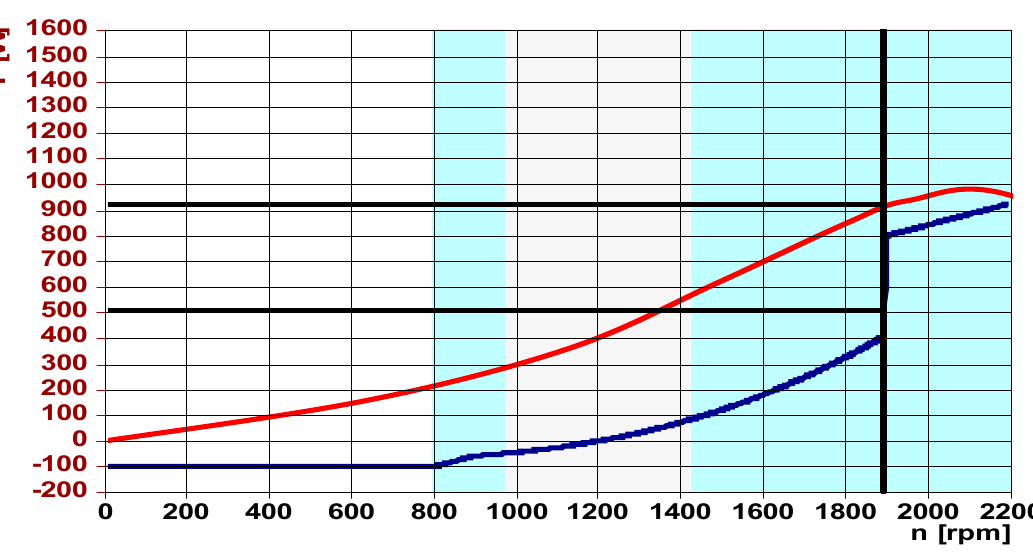
Figure 14. Wind speed based on DFIG with a speed of 10.5 m/s.